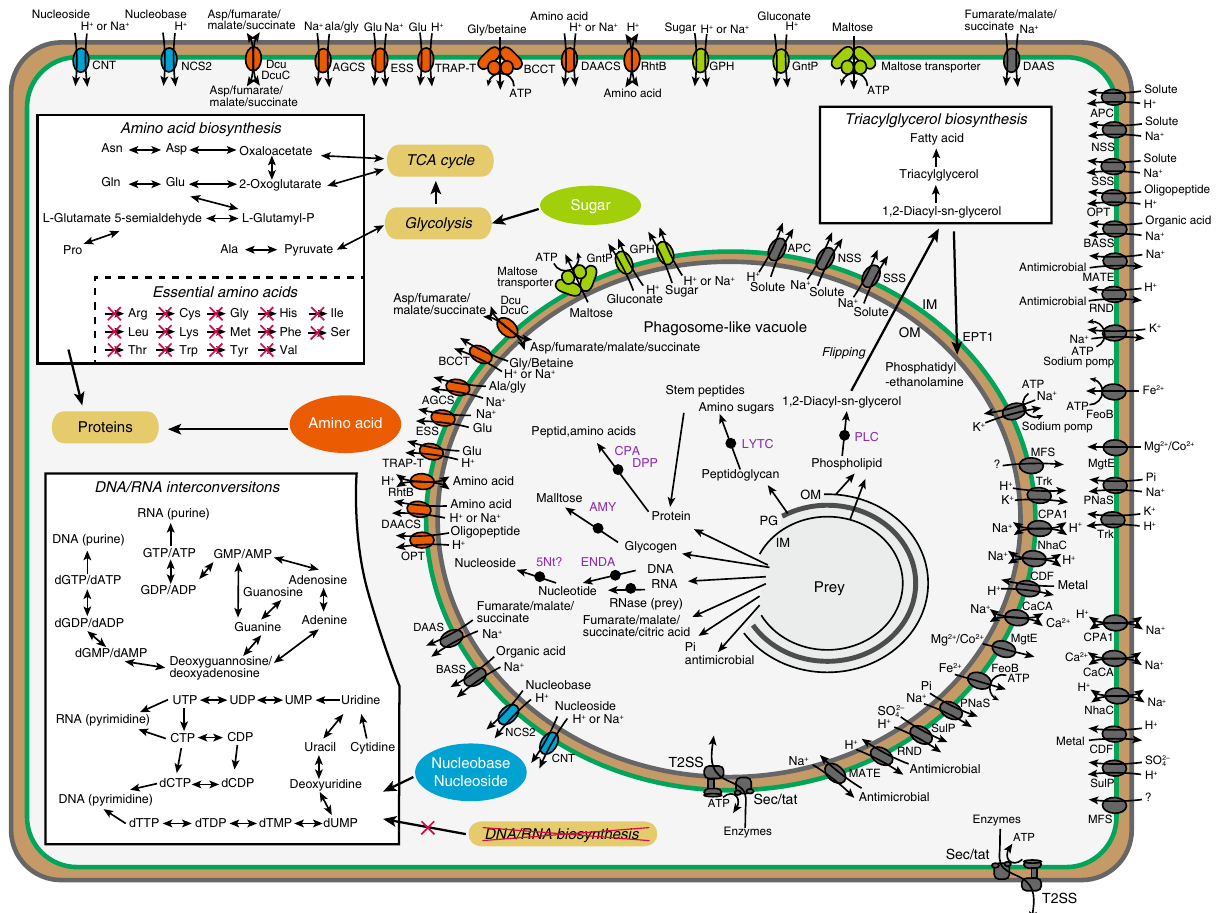
Fig. 4 Putative transporters, enzymes and pathways of ‘ Candidatus Uab amorphum ’ . Arrows indicate pathways that are present. Pathways that are absent are crossed out. Purple enzymes are predicted to be secreted in PV or localized at the outer membrane and involve to degradation of prey. Green line indicates the cytoplasmic membrane. Grey line indicates the outer membrane. Brown layers indicate periplasm. Blue circles indicate nucleoside and nucleotide transporters. Green circles indicate sugar transporters. Orange circles indicate peptide and amino acid